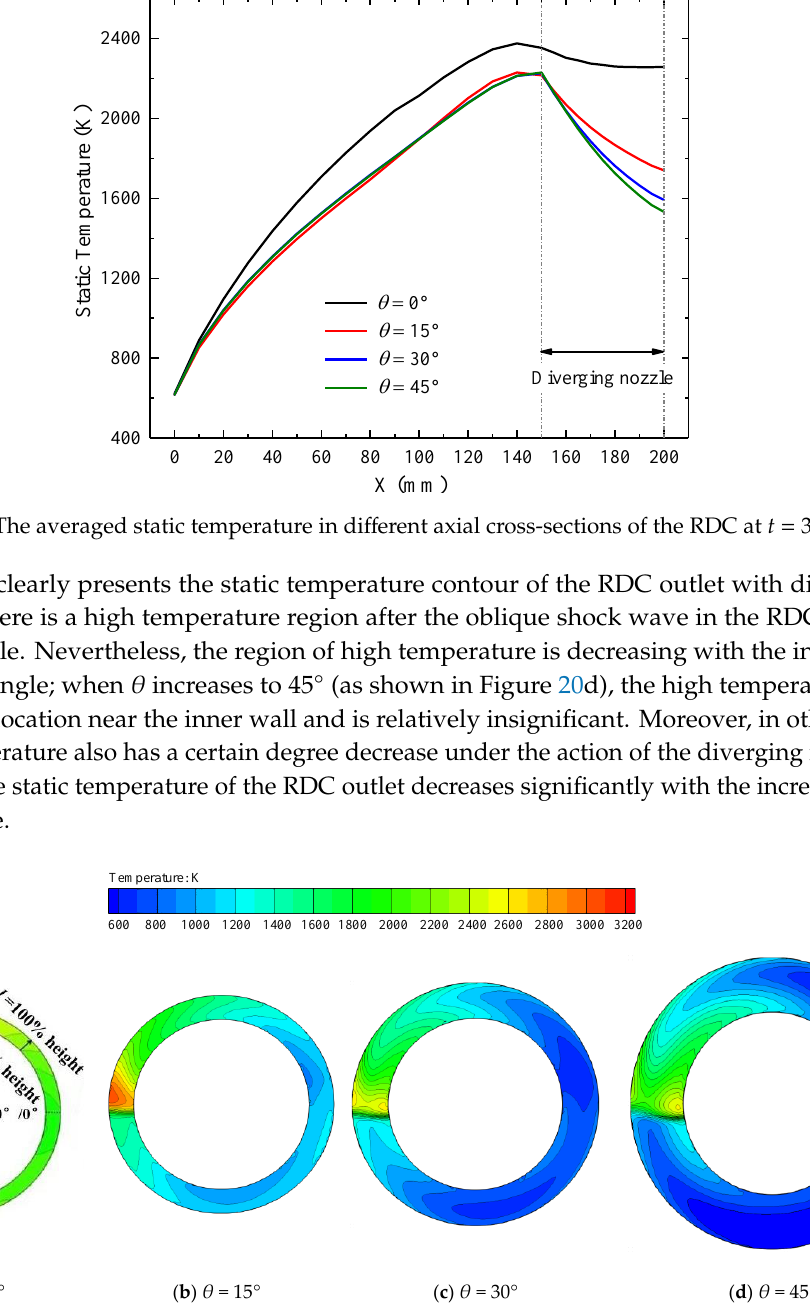
Figure 20. The outlet static temperature contour of the RDC with different θ at t = 3980 μs.